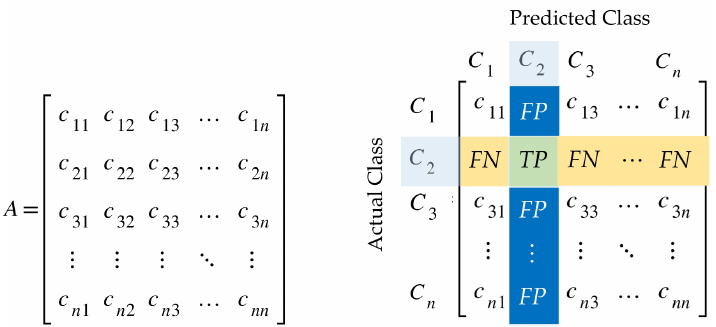
Figure 8. Confusion matrix for a multiclass classification problem.